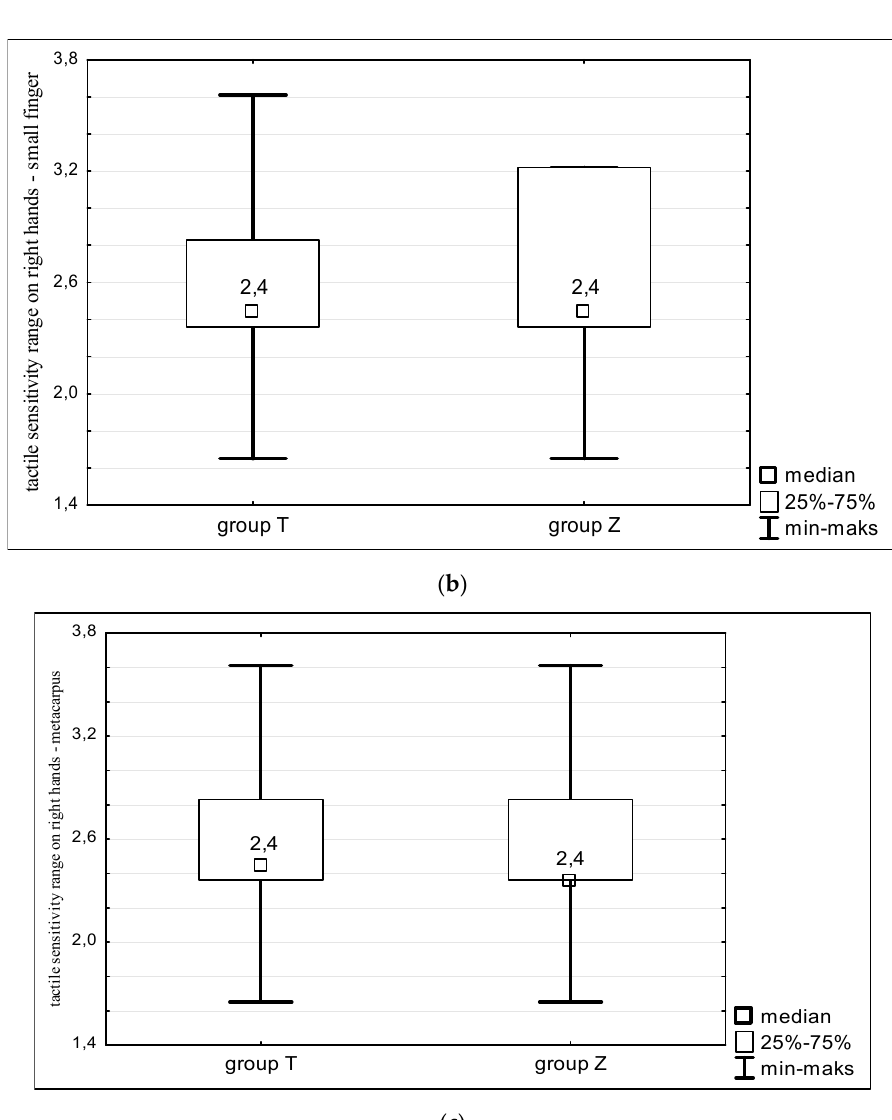
Figure 1. Tactile sensitivity of right hands of women with Turner syndrome (group T) and healthy women (group Z). Sensitivity measurements taken at: ( a ) the index finger; ( b ) small finger; and ( c ) metacarpus.